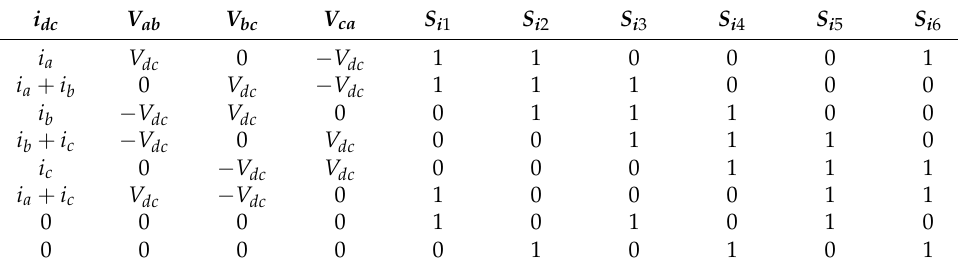
Table 2. Valid switching states of the